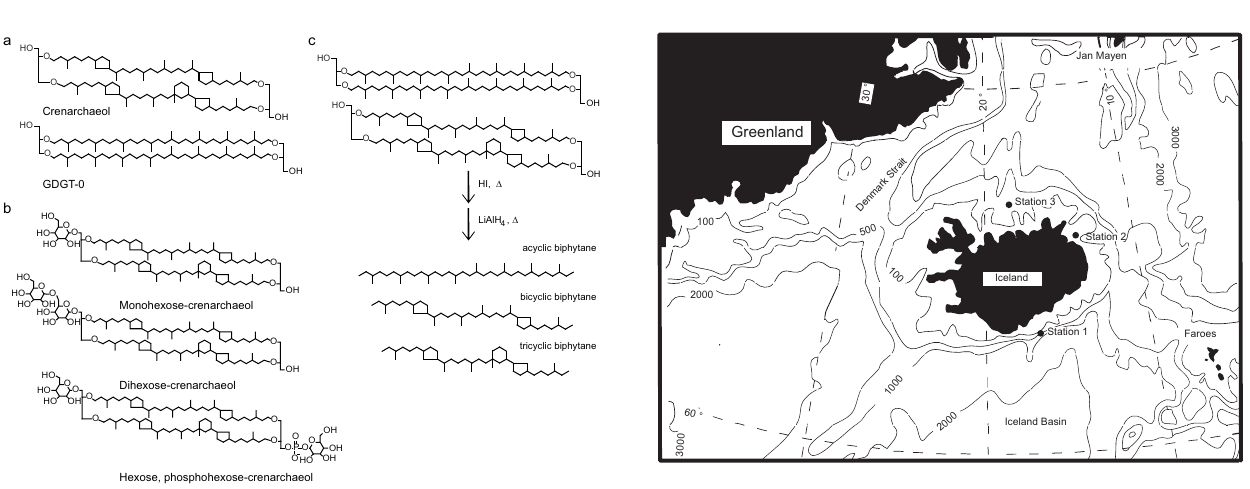
Fig. 2. Map of the sampling stations (1, 2 and 3) on the Iceland